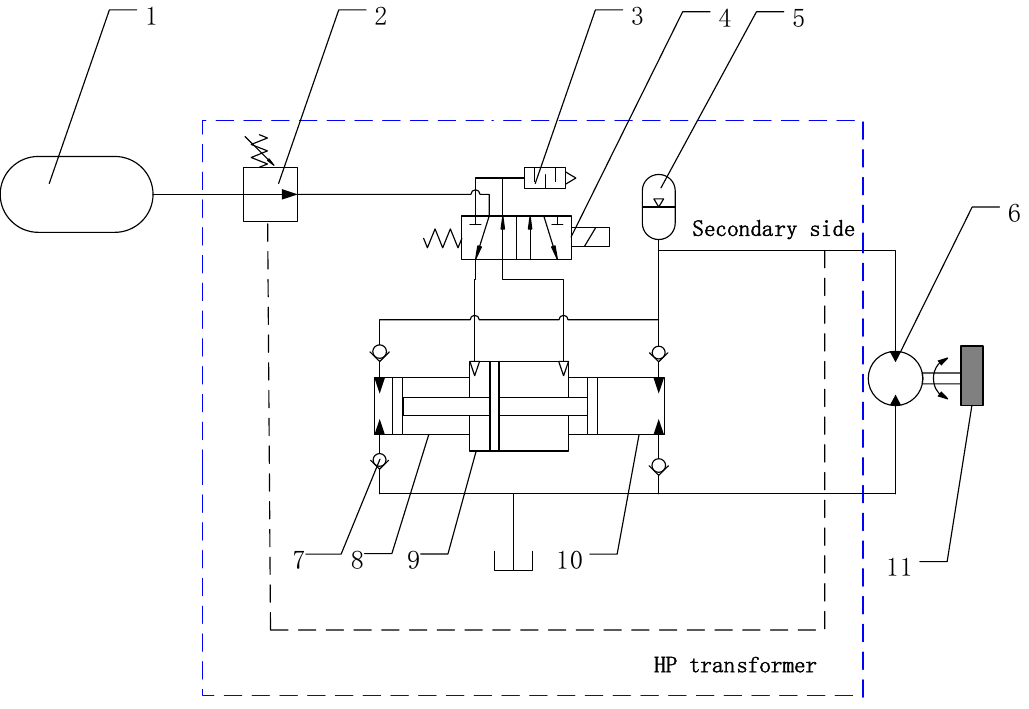
Figure 1. Composition of the compressed air-powered vehicle: 1 Air source; 2 Pressure governor; 3 Silencer; 4 Electromagnetic directional valve; 5 Accumulator; 6 Hydraulic motor; 7 Retaining valve; 8 Left hydraulic cylinder; 9 Pneumatic cylinder; 10 Right hydraulic cylinder; 11 Mechanical part.